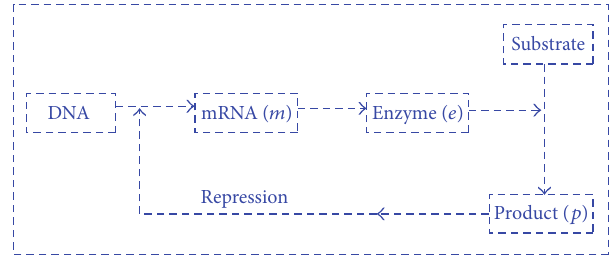
Figure 1: Regulatory scheme of the Goodwin